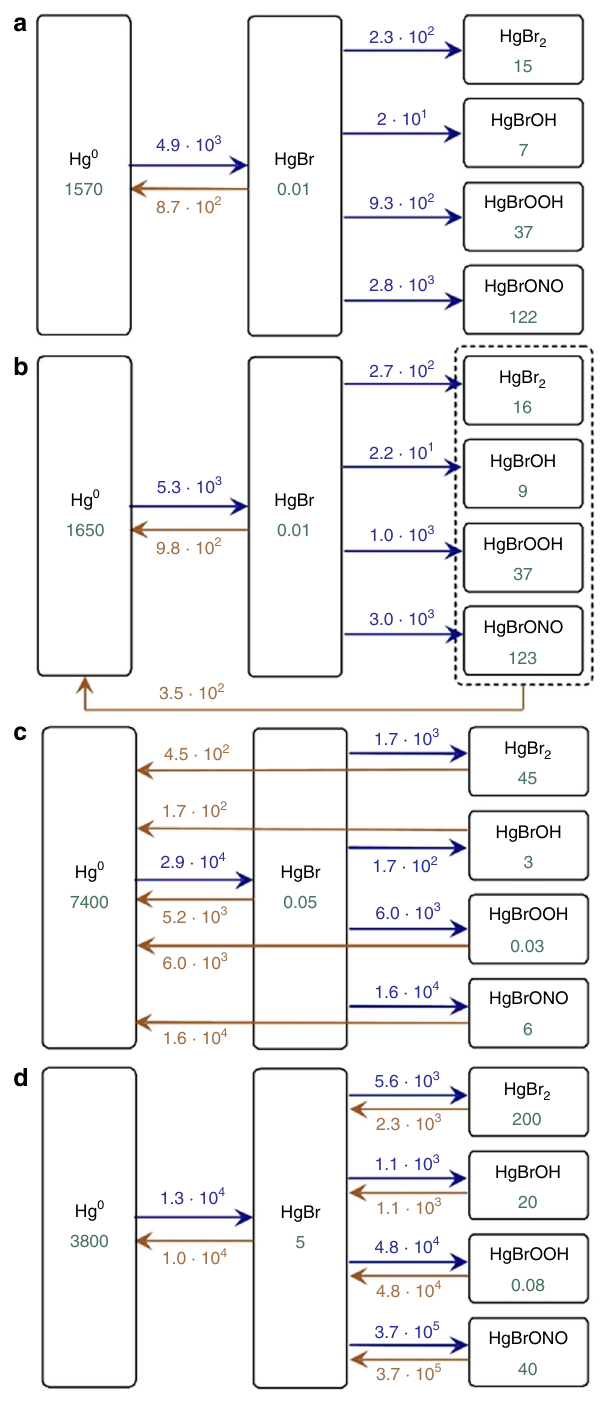
Fig. 5 Global budget of Hg chemical cycling covering the troposphere and lower stratosphere (up to ca. 30 kms) for different tests in GLEMOS: a — Run #1; b — Run #2; c — Run #3; d — Run #4. The mass estimates are in Mg, the fl uxes are in Mg a − 1